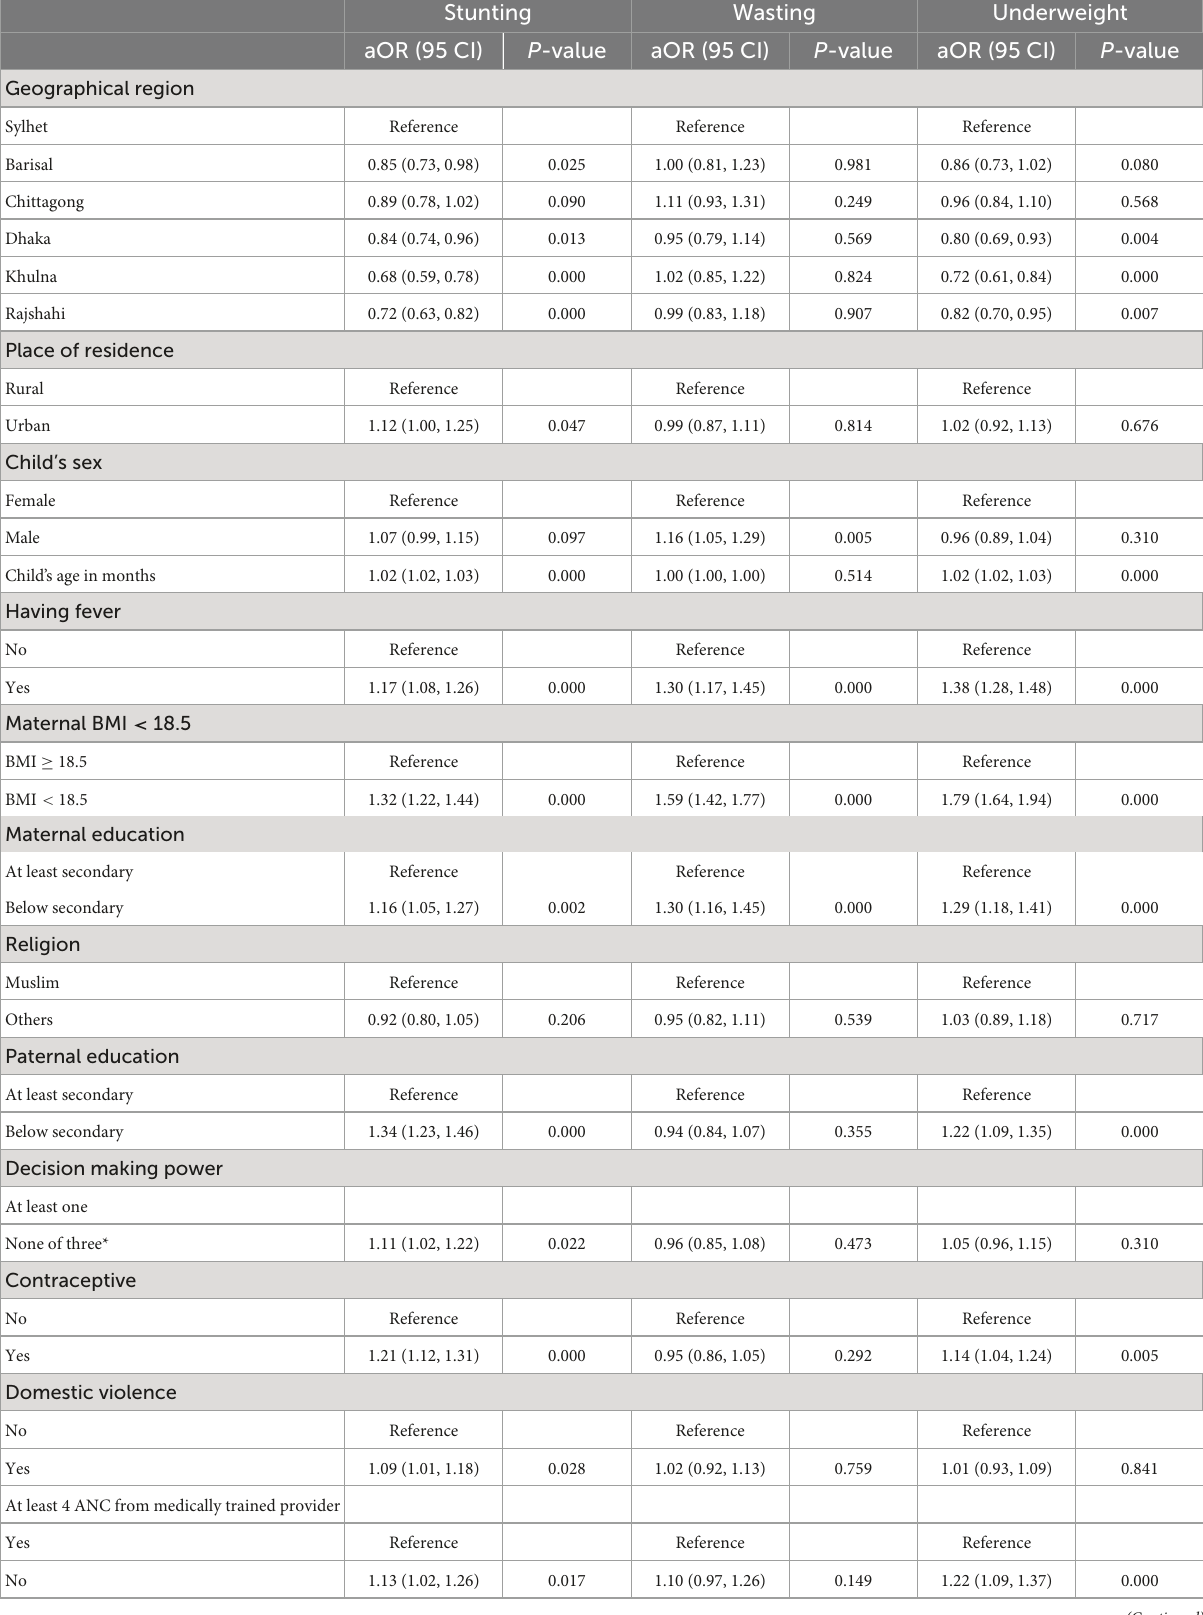
TABLE 2 Factors associated with childhood stunting, wasting and